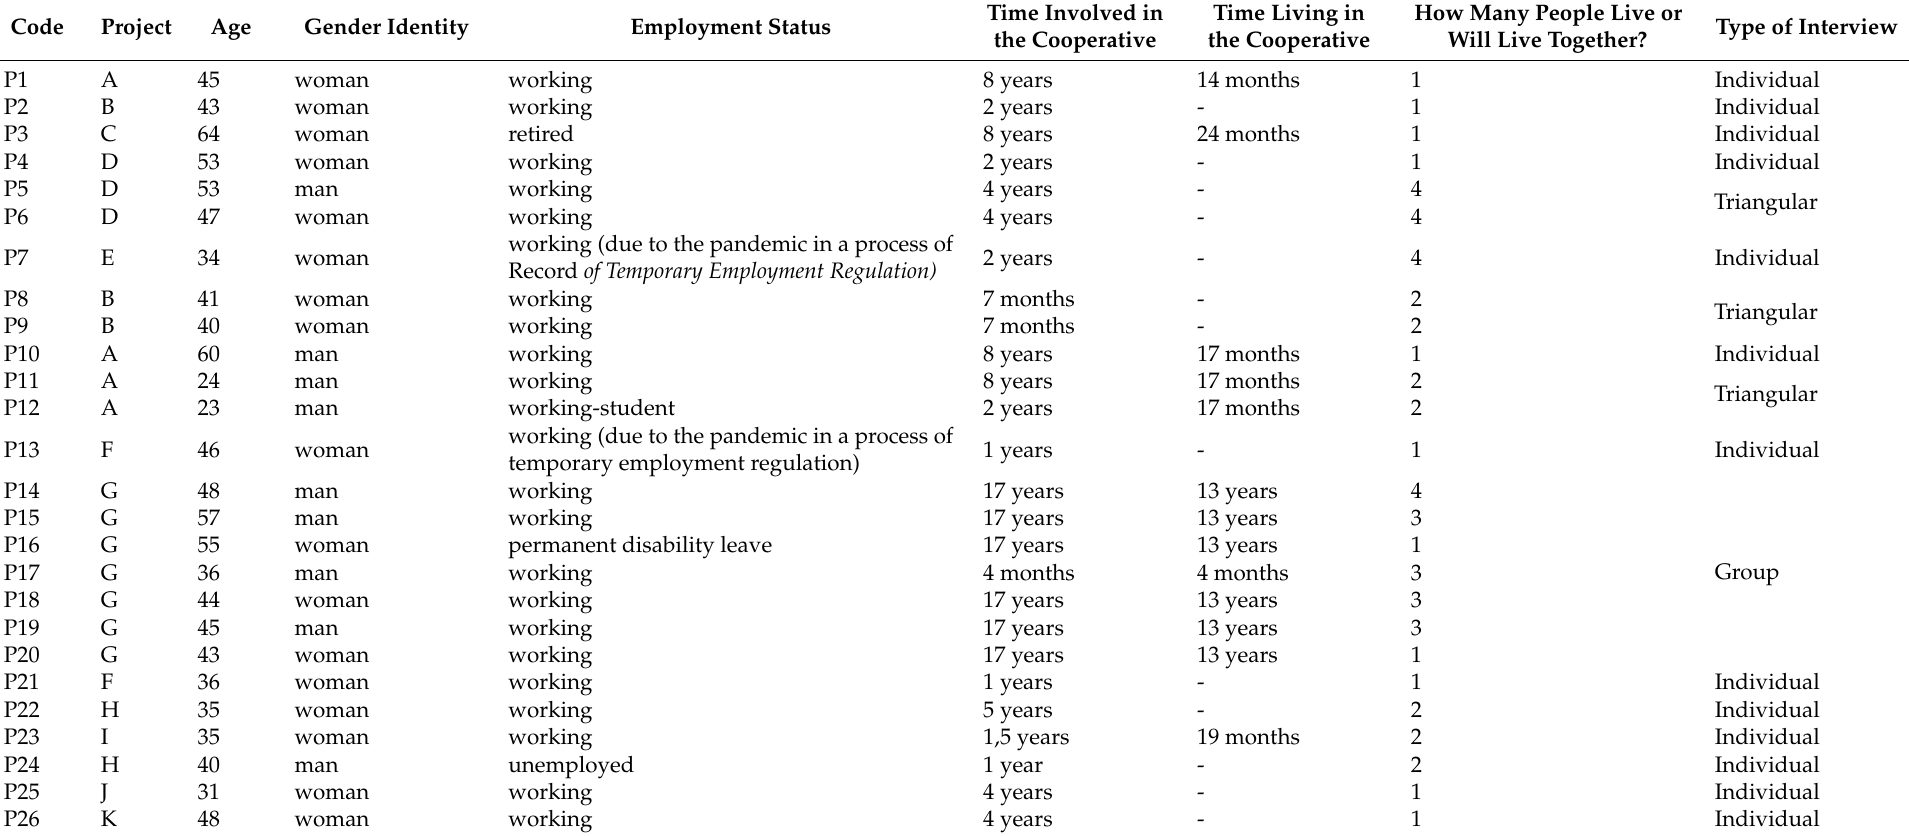
Table 2. Description of main characteristics of the participants (elaborated by the authors